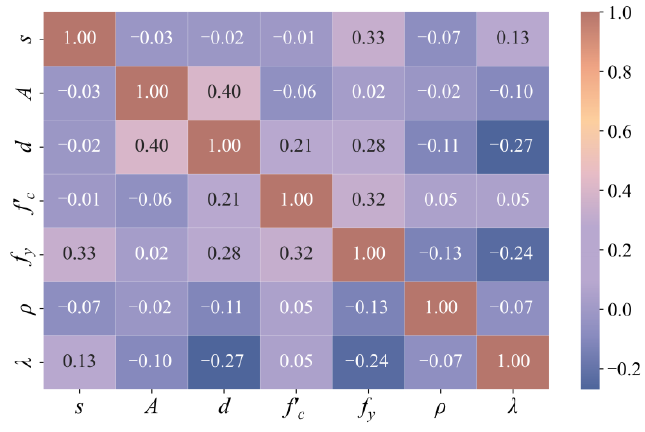
Figure 3. Correlation coefficient matrix of input variables.